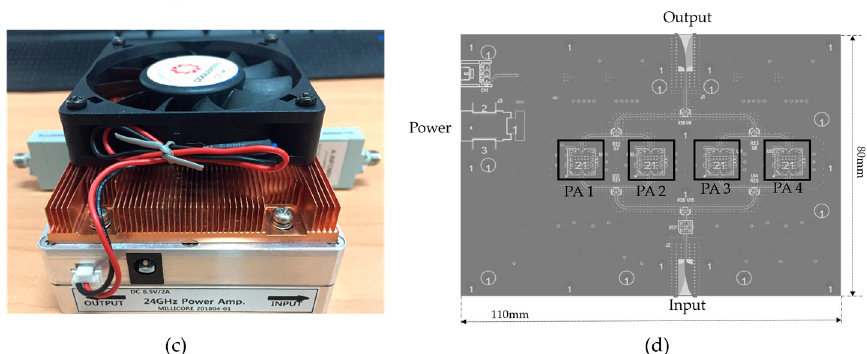
Figure 9. ( a ) Photograph of Adopted Analog Devices evaluation board; ( b ) layout of the Analog Devices evaluation board; ( c ) photograph of the designed 24-GHz power amplifier (PA); ( d ) layout of the designed 24-GHz power amplifier (PA).